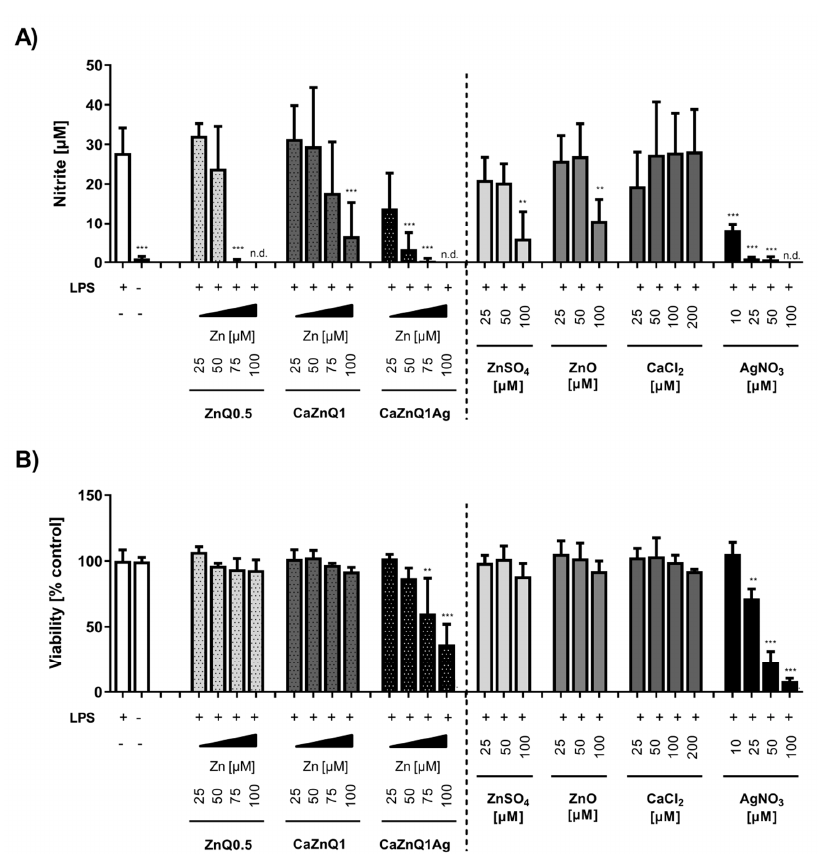
Figure 6. Impact of aerogel swelling supernatants on LPS-induced nitric monoxide production in RAW 264.7 cells. Supernatants from aerogels or metal salt solutions generated in SBF-albumin were applied on RAW 264.7 macrophage cells to study their impact on bacterial LPS-induced NO ● production, measured by its stable degradation product nitrite ( A ), and the corresponding viability ( B ) of RAW 264.7 cells. The designations on the X axes state the final amounts of aerogel-derived zinc and the final concentration of metal salts within the incubations. n.d. = not detected. Data are presented as means ± SEM of three independent experiments. Statistically significant differences from LPS-treatment ( A ) or control ( B ) are marked by asterisks (** p < 0.01, *** p < 0.001; One-Way ANOVA with Tukey’s Multiple Comparison Test).